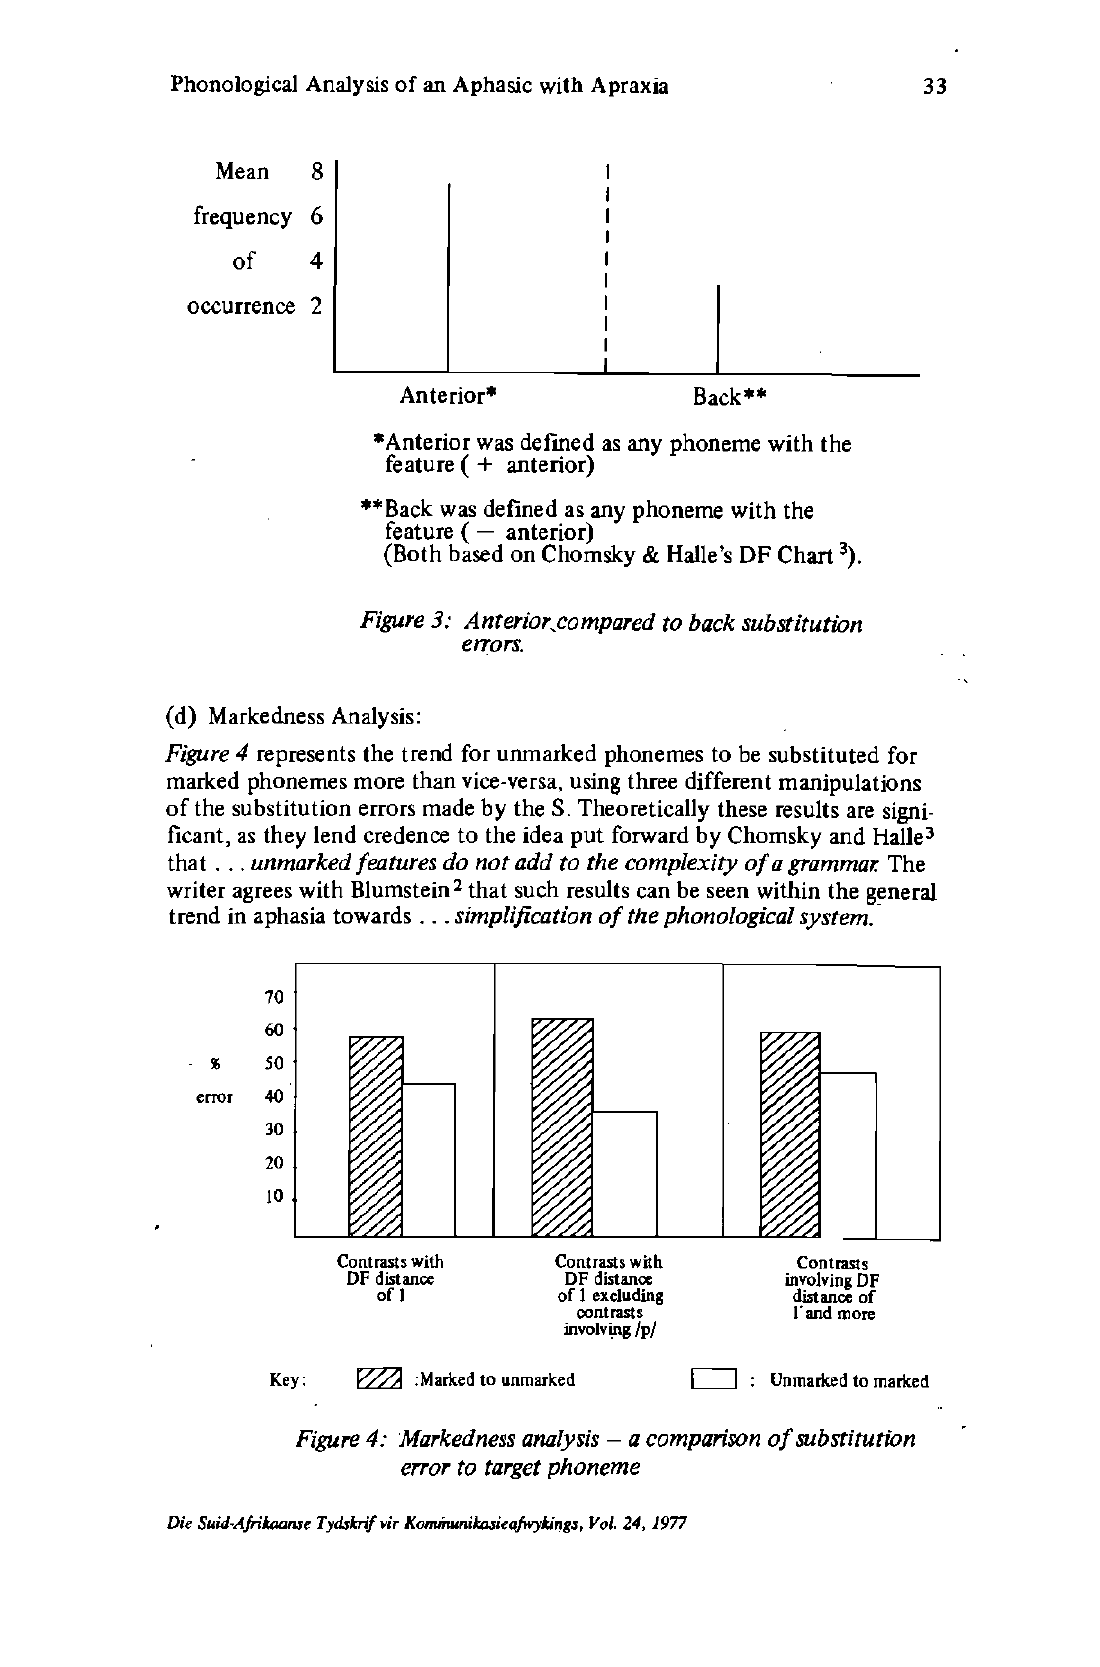
Figure 4: Markedness analysis - a comparison of substitution error to target